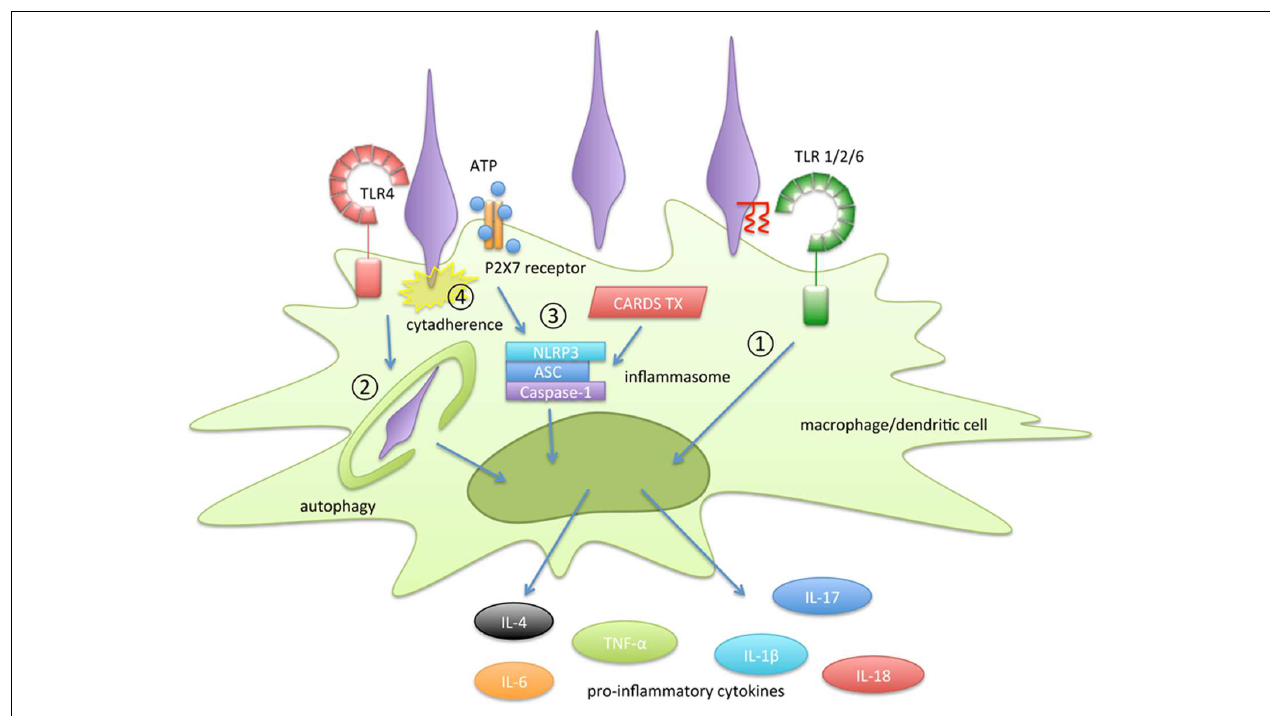
FIGURE 2 | Summary of the inflammation-inducing pathways in Mycoplasma pneumoniae infection. The following four pathways are involved in the induction of inflammatory responses: (1) recognition of lipoprotein by TLR2, (2) autophagy-mediated signaling, (3) activation of inflammasomes, and (4) cytadherence